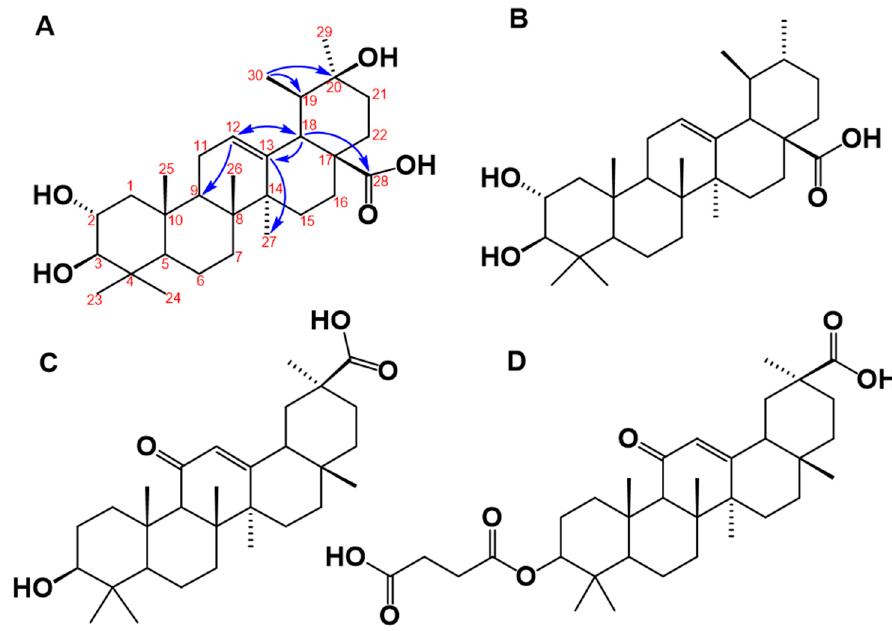
Figure 4. ( A ) Proposed chemical structure of the triterpene molecule named isoyarumic acid isolated from C. telenitida. The numbers indicate carbon positions and the arrows are the most prominent correlations detected in the HMBC experiment. ( B ) Chemical structure of the related natural triterpene, corosolic acid, which is a reported inhibitor of 11 β -HSD1. ( C ) Chemical structure of glycyrrhetinic acid. ( D ) Chemical structure of the synthetic molecule known as a carbenoxolone.